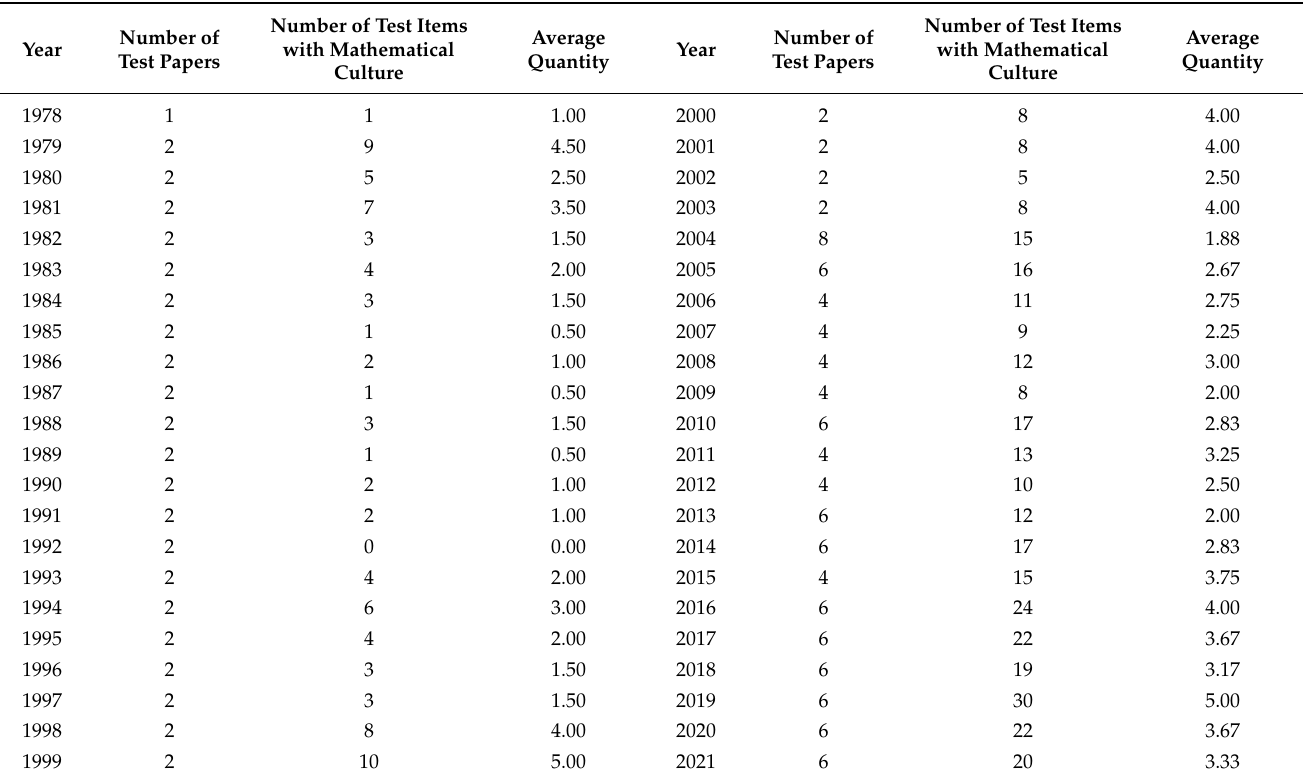
Table A2. Number of test items with mathematical